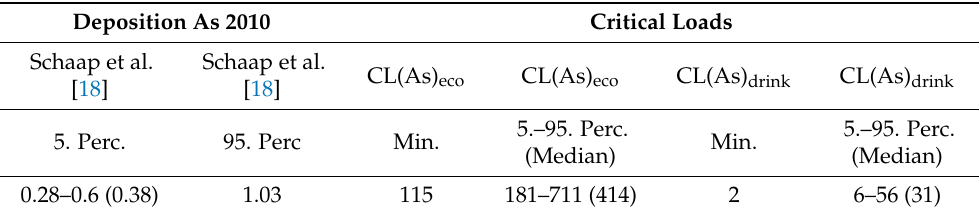
Table 9. Comparison of As deposition in 2010 (in g ha − 1 a − 1 ) with the CL (in g ha − 1 a − 1 ) of receptor surfaces in Germany.